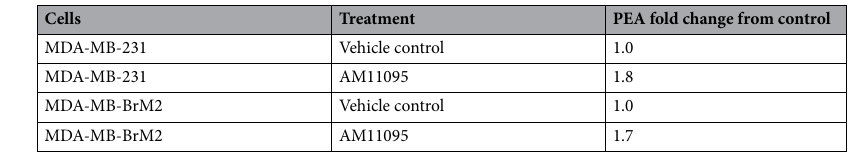
Table 3. Effects of AM11095 on PEA secretion. The effect of AM11095 on levels of PEA by incubating MDA-MB-231 cells (10 6 ) with 250 nM concentration or vehicle control for 72 h. Cells were harvested and lysed, and PEA levels in cell lysates were measured using LC–MS method. Results are expressed as PEA fold change from control. Values are expressed as means (n = 3).